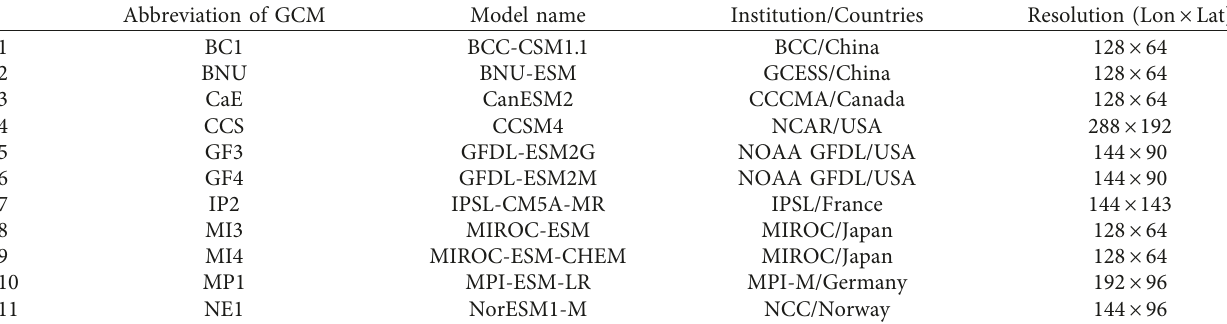
Table 2: CMIP5 climate model information.